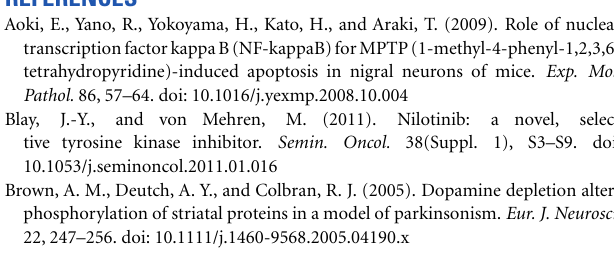
** P < 0.01 versus mice with saline + vehicle or MPTP + NTB; one-way ANOVA [ F ( 2,12 ) = 11.91] followed by Scheffe test. (B) Western blot analysis of striatal levels of DARPP-32-pThr75, DARPP-32-pThr34, and total DARPP-32 in mice treated with saline + vehicle (control), MPTP + vehicle, or MPTP + NTB. Values are means ± SEM ( n = 5). ** P < 0.01 versus mice with saline + vehicle or MPTP + NTB; one-way ANOVA [ F ( 2,12 ) = 11.77] followed by Scheffe